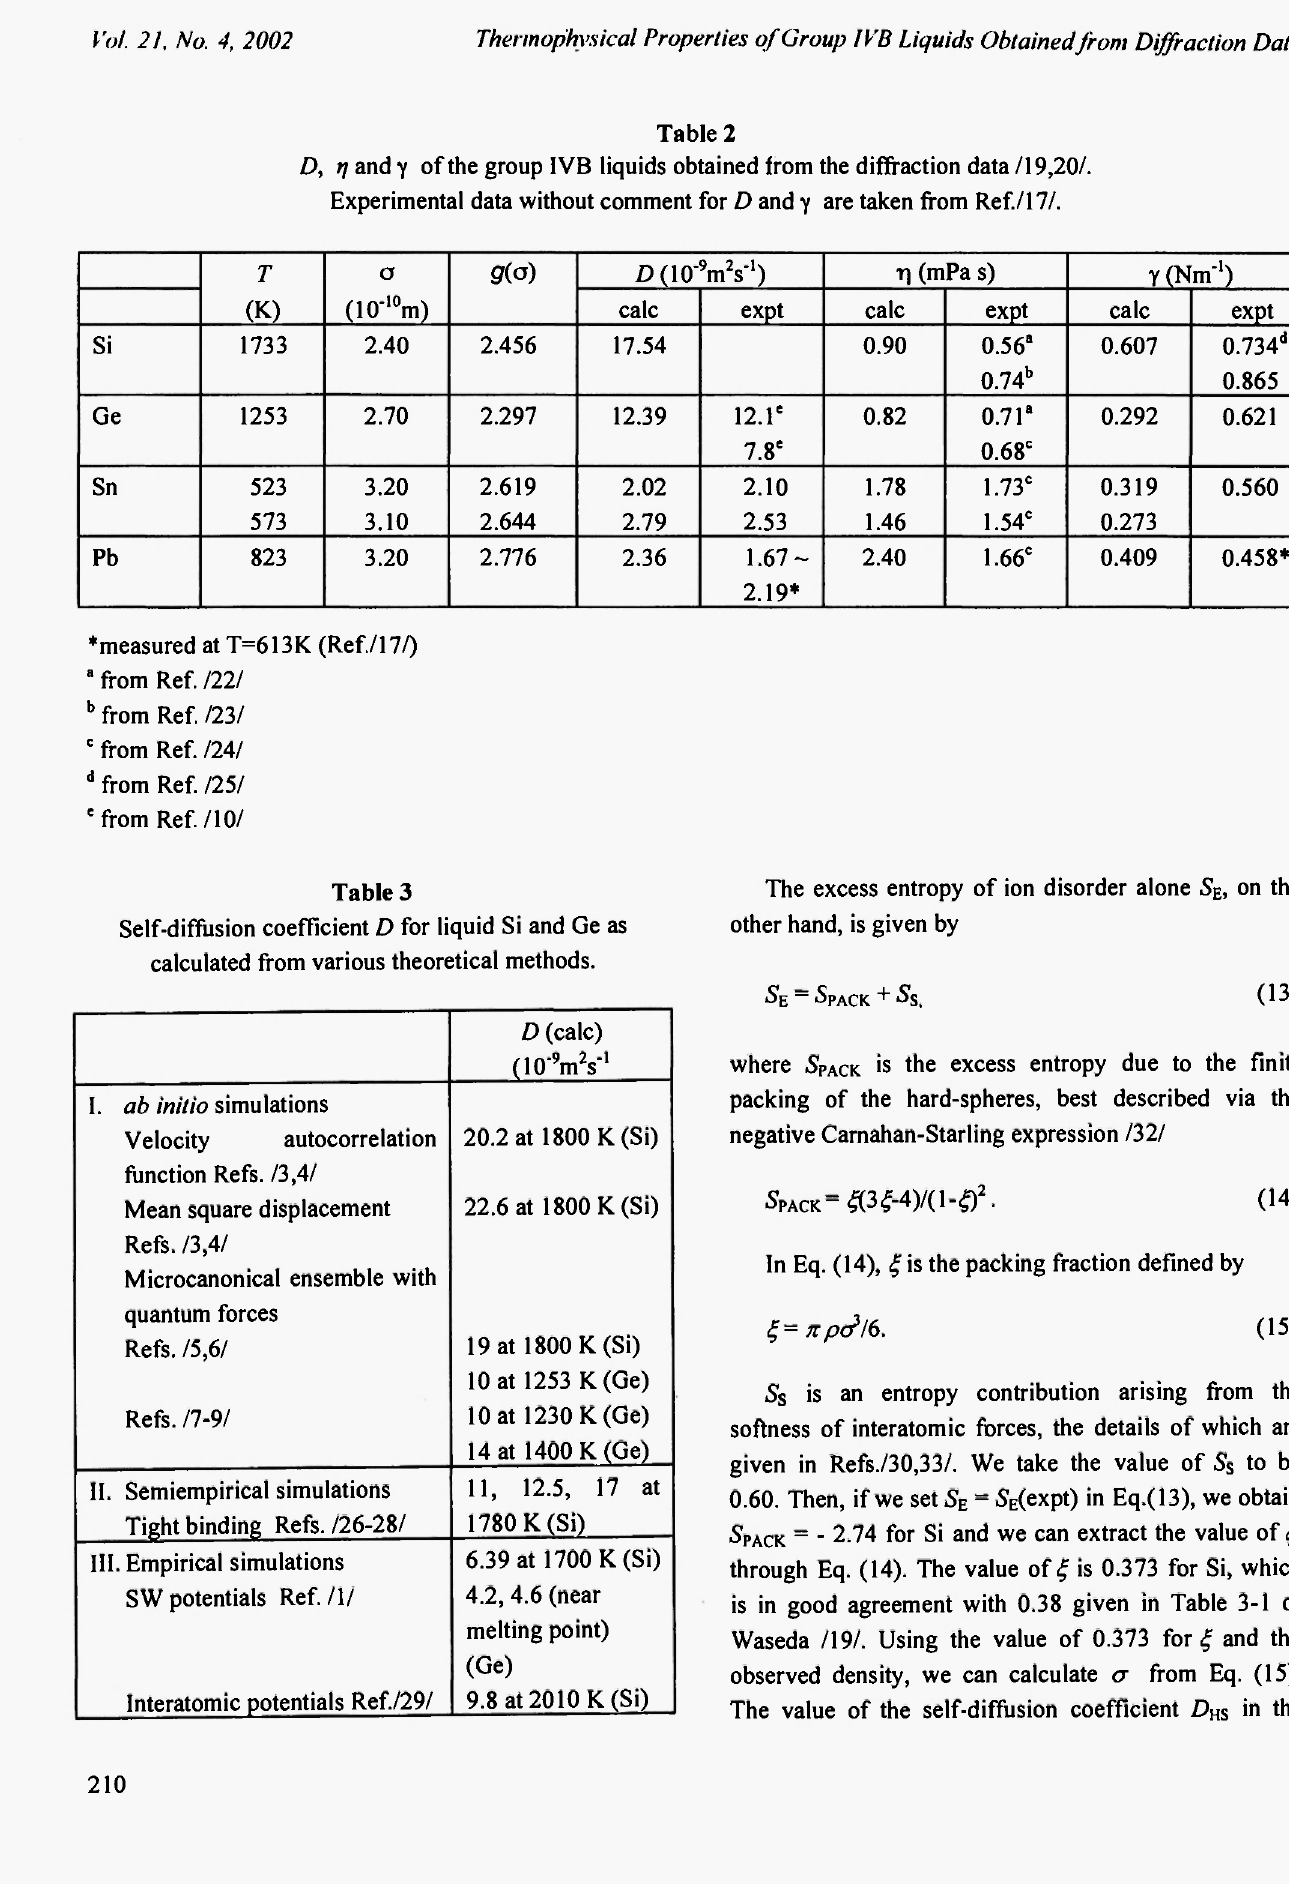
Self-diffusion coefficient D for liquid Si and Ge as calculated from various theoretical